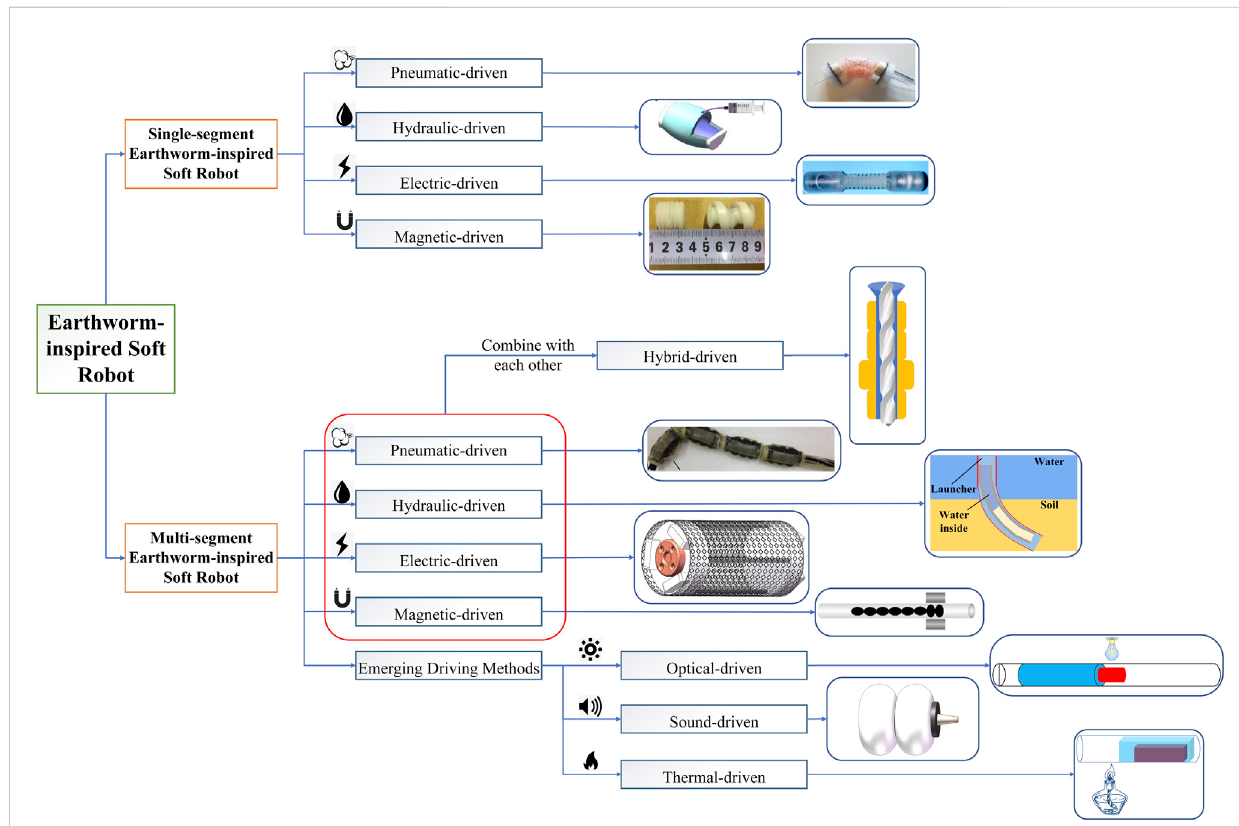
FIGURE 1 Chartofvarioustypesofearthworm-inspired softrobotsdiscussedinthisreviewarticle,classi fi edbasedonactuationmethodsandnumberofbody segments(Kimetal.,2006;Yanagidaetal.,2012;Wangetal.,2018a;Guoetal.,2018;HuandCheneler,2021;Youetal.,2021).FromRef.(Guoetal.,2018; Hu and Cheneler, 2021; You et al., 2021), used under Creative Commons CC-BY license. Reproduced from Ref (Kim et al., 2006; Yanagida et al., 2012; Wang et al., 2018a) with